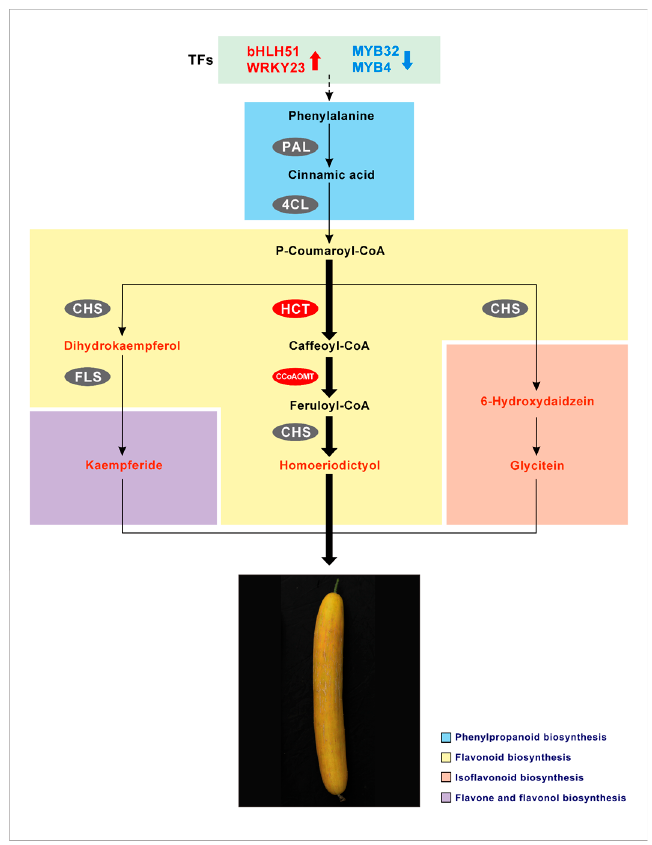
Figure 7. Prediction new model of cucumber peel yellowing. The red arrow indicated up-regulated. The blue arrow indicated down-regulated. TFs, Transcription Factors. PAL, Phenylalanine ammonia-lyase; 4CL, 4-coumarate-CoA ligase; HCT, Shikimate O-hydroxycinnamoyltransferase; CCoAOMT, Caffeoyl-CoA O-methyltransferase; CHS, Chalcone synthase; FLS, Flavonol synthase. MYB and bHLH (basic helix-loop-helix) TFs exist in all eukaryotes, and they are the largest two families of plant transcription factors [75]. AtWRKY23 in Arabidopsis thaliana (L.) can stimulate flavonoid biosynthesis by upregulating enzyme encoding genes involving in flavonoid biosynthesis pathway [76]. The abnormal expression of bHLH3 in mulberry fruits and proportion of anthocyanins, flavonoids and flavonols in different colors of mulberry fruits [77]. It has been shown that transcription factors such as MYB, bHLH protein and